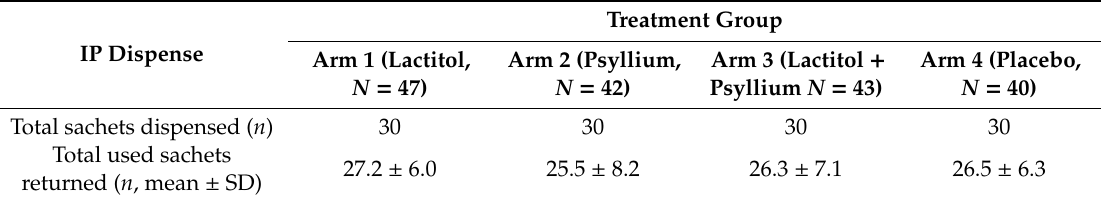
Table 2. Summary of Study Product Dispensing (IP Compliance) in ITT Population ( N =